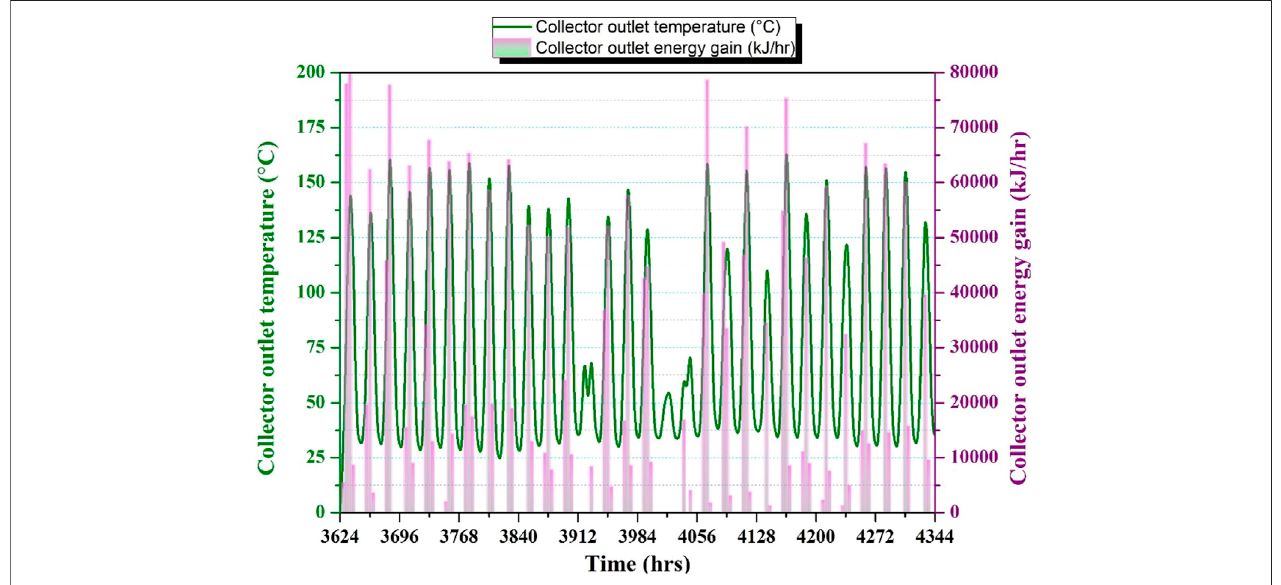
FIGURE 6 | Cooling outlet temperature and energy